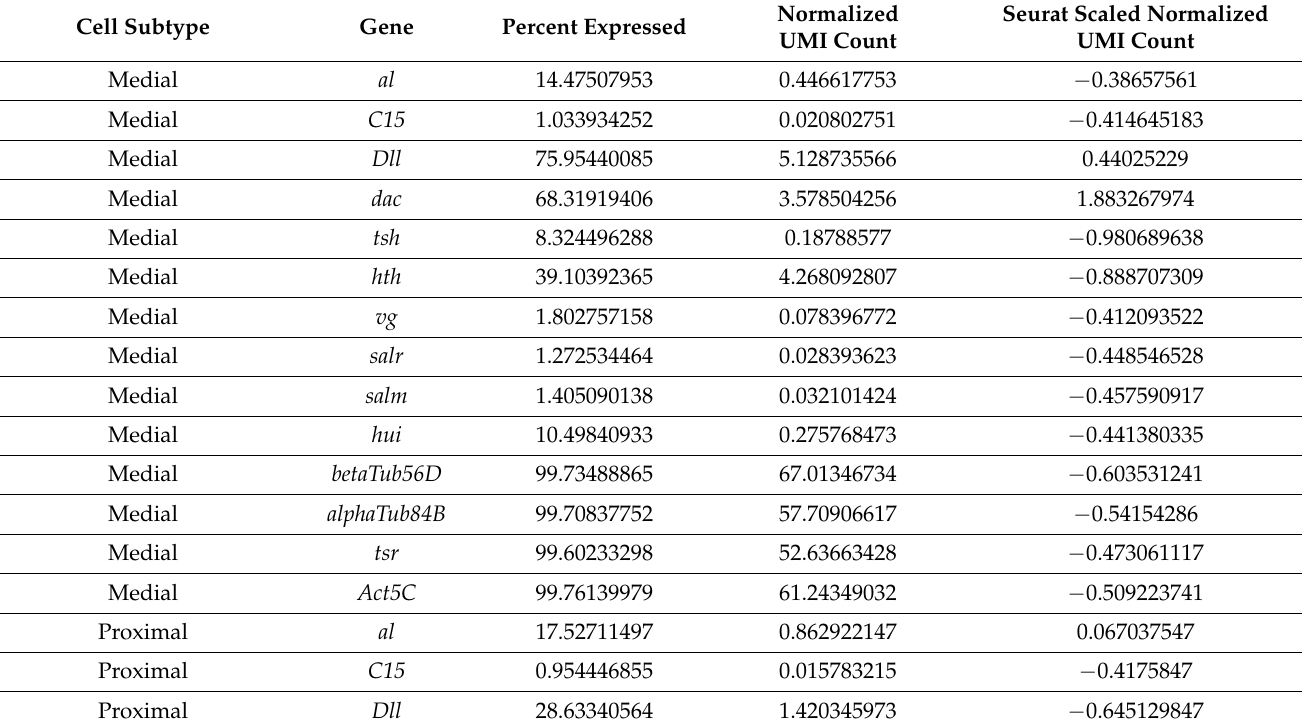
Table A1. Relative expression levels of marker genes. The average log2FC expression levels of the marker genes displayed in Figures 1 and 2 are tabulated